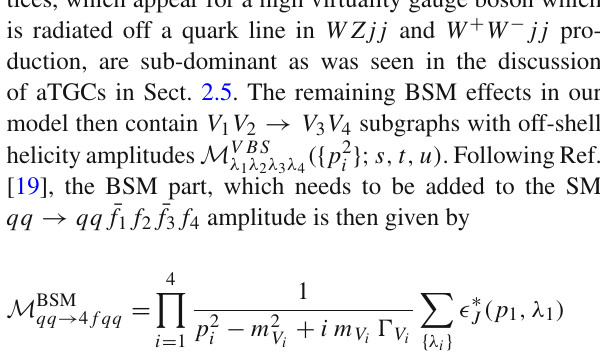
tices, which appear for a high virtuality gauge boson